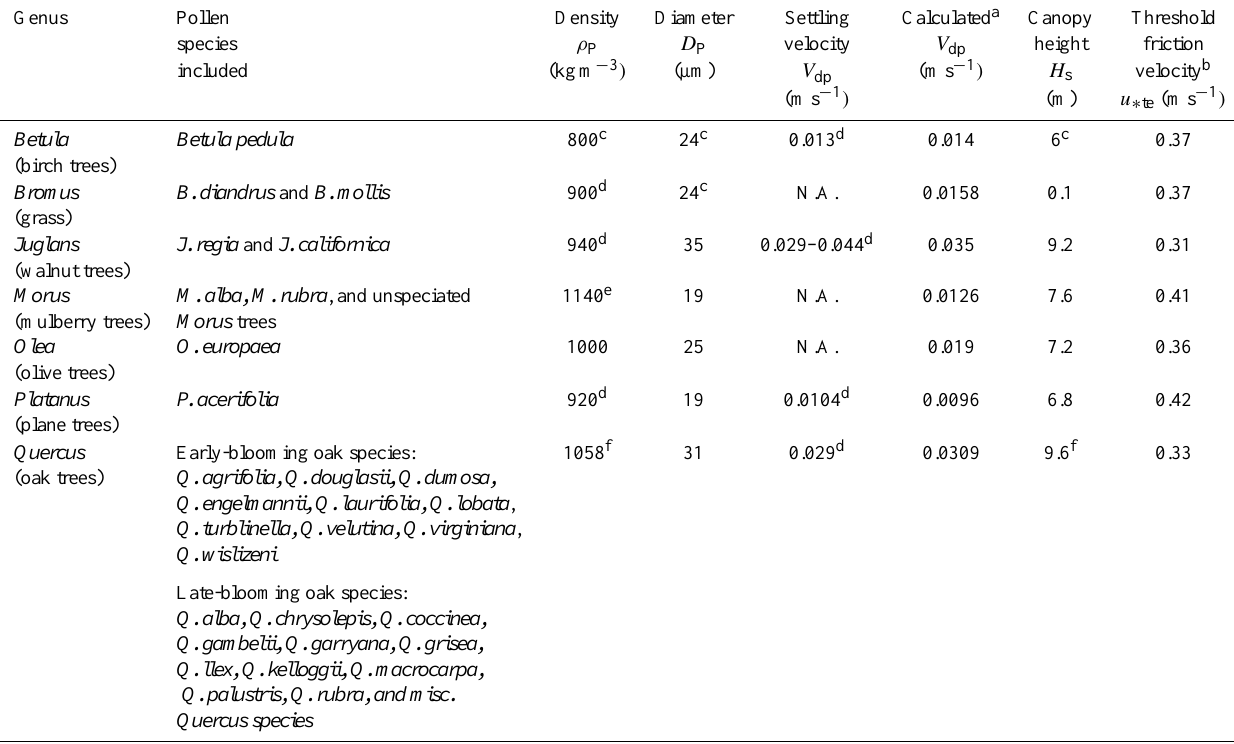
Table 1. Pollen genera considered in this study and their physical properties. Note: N.A. indicates not available. Genus Pollen Density Diameter Settling Calculated a Canopy Threshold species ρ P D P velocity V dp height friction included (kgm − 3 ) (µm) V dp (ms − 1 ) H s velocity b (ms − 1 ) (m) u ∗ te (ms − 1 ) 800